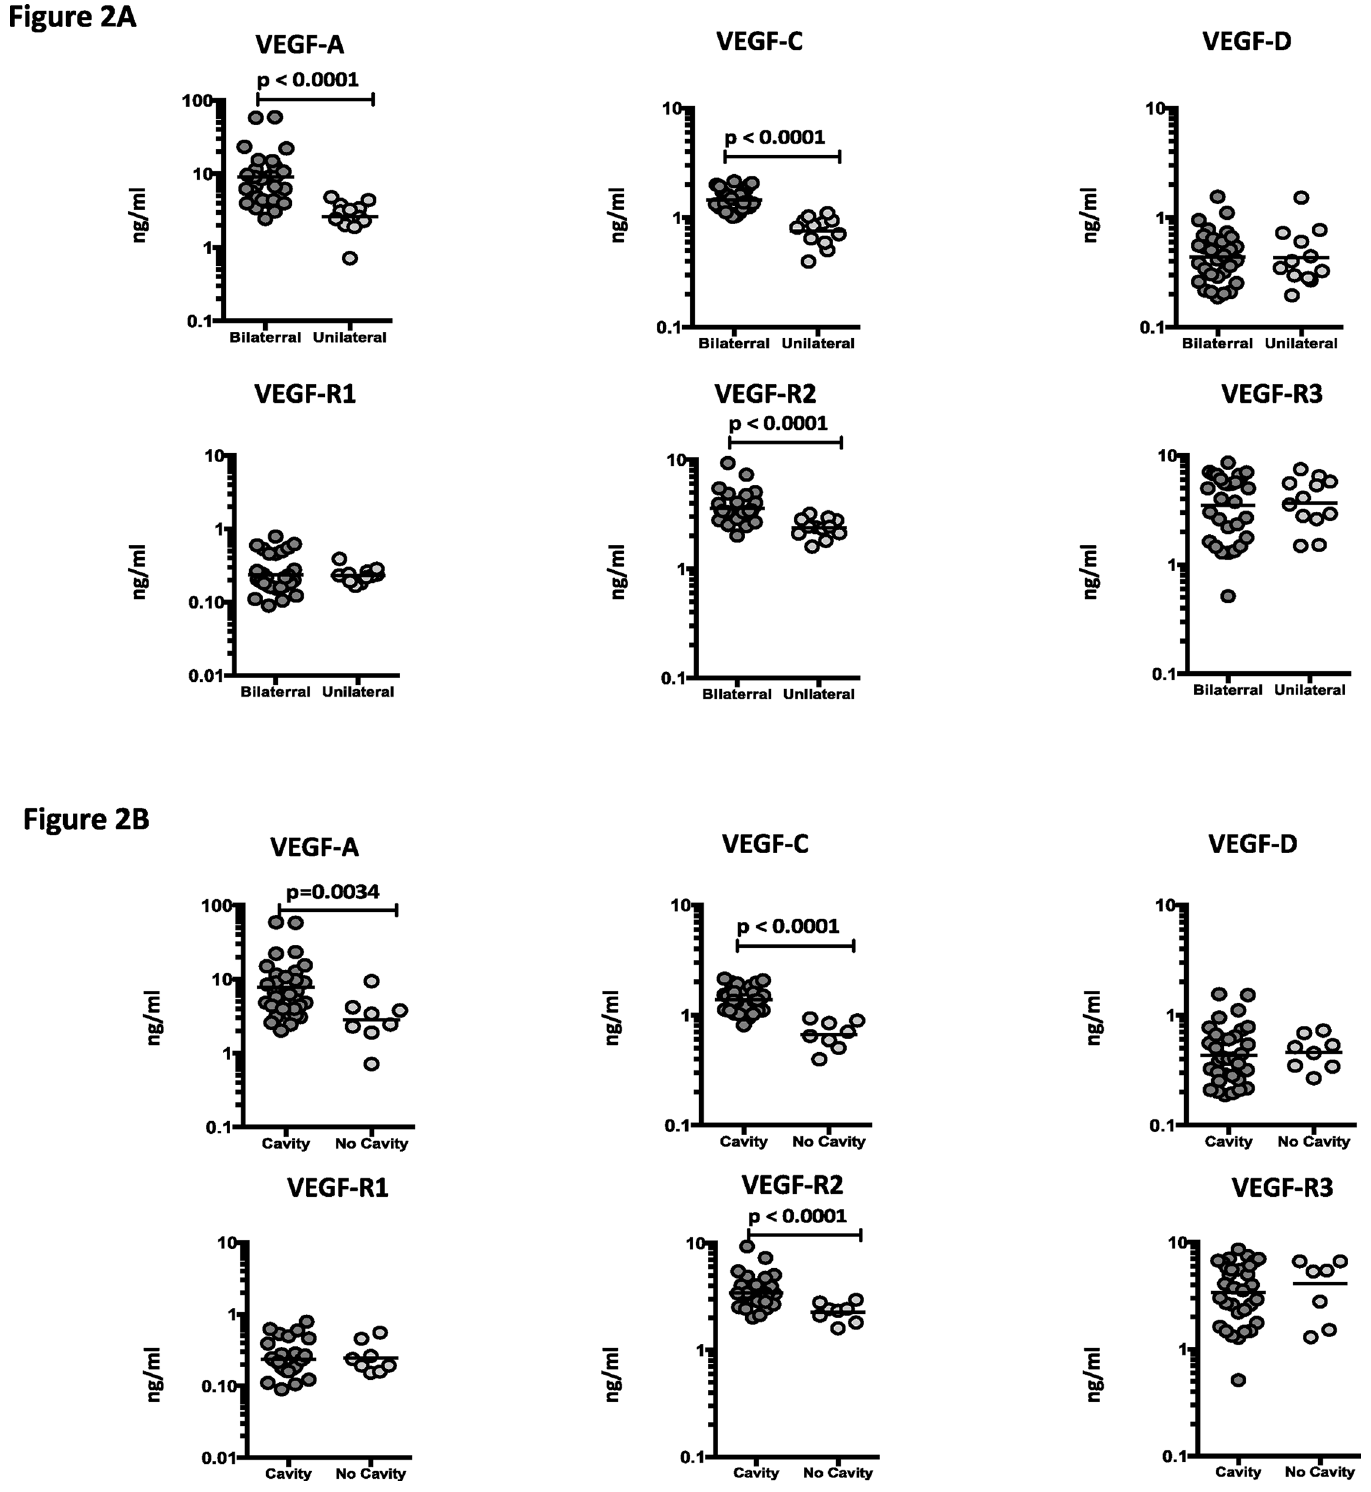
Fig 2. Elevated systemic levels of VEGF-A, VEGF-C and VEGF-R2 in bilateral and cavitary disease in PTB individuals. (A) The plasma levels of VEGF-A, C and D, VEGF-R1, R2 and R3 were measured in PTB individuals with bilateral versus unilateral disease. (B) The plasma levels of VEGF-A, C and D, VEGF-R1, R2 and R3 were measured in PTB individuals with cavitary versus non-cavitary disease. The data are represented as scatter plots with each circle representing a single individual. P values were calculated using the Mann-Whitney test.